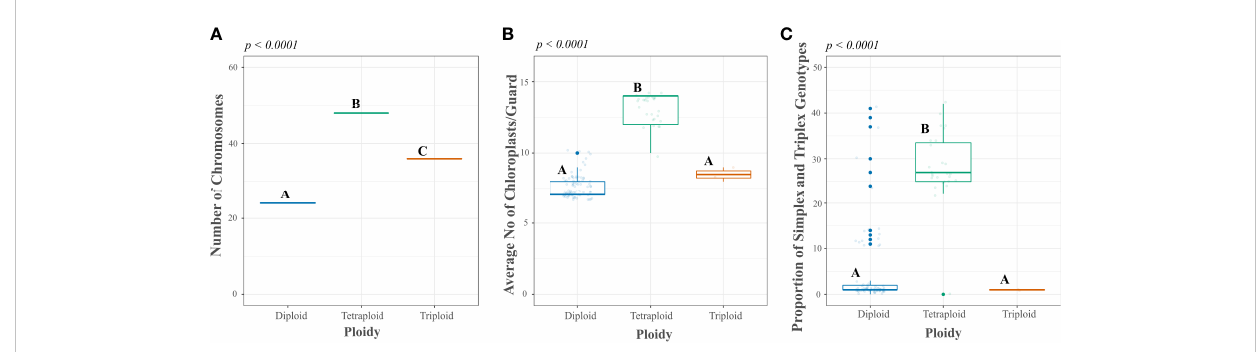
FIGURE 3 Comparison of direct and indirect methods of ploidy assessment in a reference set of accessions from the Colombian Central Collection (CCC) of potatoes. Y-axes show the measurement scales of direct and indirect methods: (A) chromosome count in the root tips, (B) chloroplast count per guard cell, and (C) proportion of simplex and triplex (ABBB, AAAB) Single Nucleotide Polymorphic (SNP) genotype scores per sample, compared to the x-axes with the ploidy base on the direct method of ploidy assessment. The p-values correspond to the ANOVA signi fi cance, while the different letters correspond to test results using a Tukey test in R